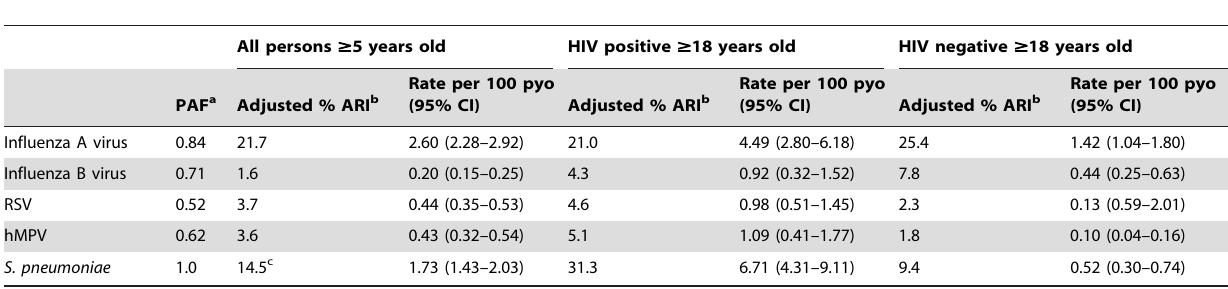
Table 6. Incidence of select pathogens found to have an association with ARI case status, western Kenya. March 1, 2007,-February 28,